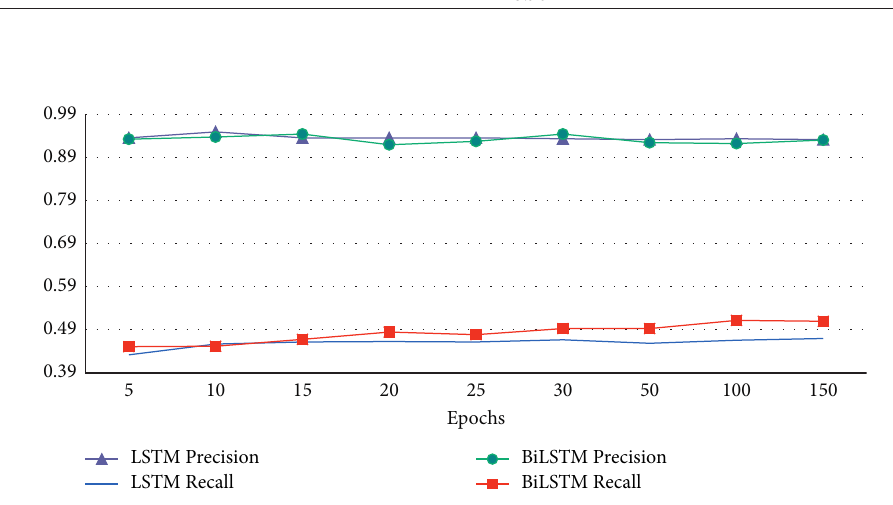
Figure 5: Performance of NN-QuPiD Attack with RNN algorithm and query string feature vector under different